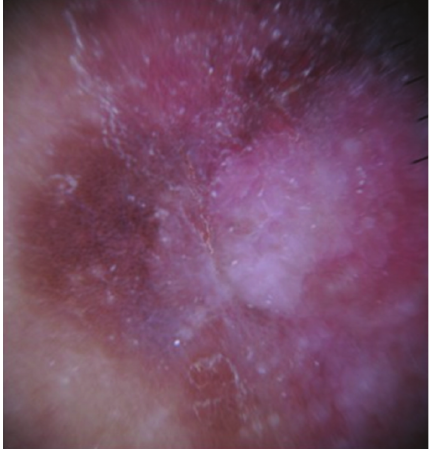
Figure 10: Case 2. Closeup view of “cotton candy” keratosis, kerati- nous rim and peripheral brown globules in linear